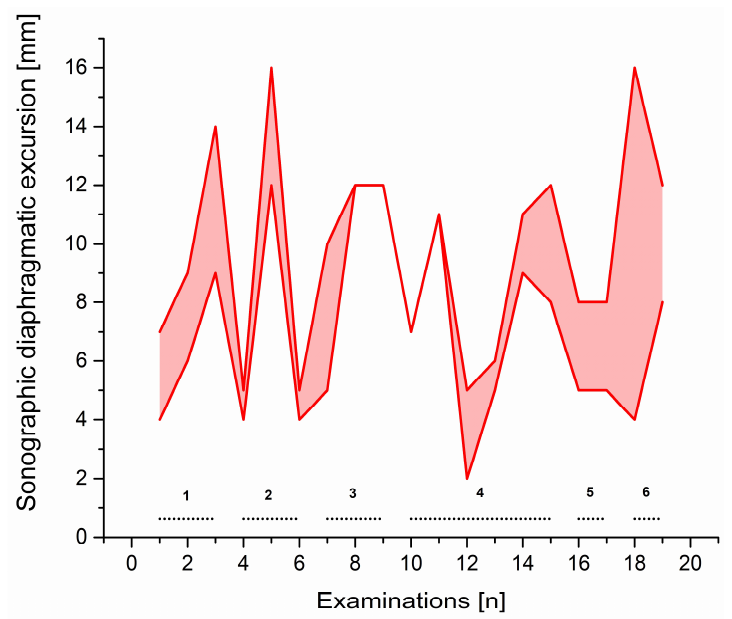
Figure 3. Diaphragmatic excursion during the six distinct weaning phases in patient #3. Diaphrag- matic excursion measured by diaphragm sonography during a prolonged weaning period in a patient with Pompe disease. Upper red line depicts maximum diaphragmatic excursion and lower red line minimal diaphragmatic excursion during the examination period. The six distinct weaning phases and drawbacks are described in the main text.